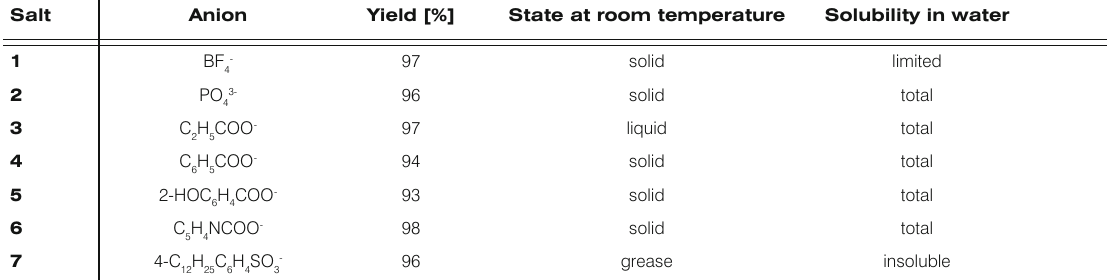
Table 1. Prepared salts.